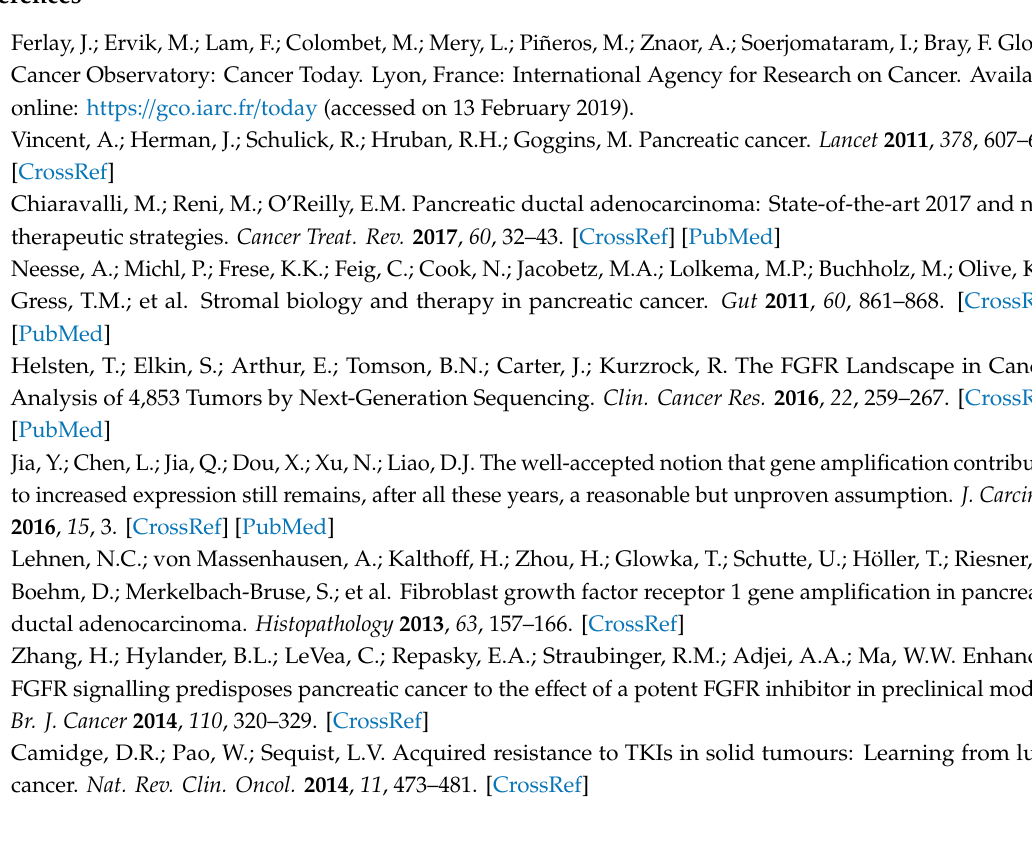
Figure S1. Aberrant FGFR1 and PARP1 expression is associated with cancer stem cell-like phenotype, regulates DNA repair, and modulates response to therapy in PDAC cells. Image showing the bioinformatics-generated gene expression-based heatmap of FGFR1, PARP1, ALDH1A1, ABCB1, RAD51, and H2AFX genes in the TCGA pancreatic adenocarcinoma cohort with the gene locus indicated; Figure S2. Dot and line plots of the correlation among FGFR1, PARP1, ALDH1A1, ABCB1, RAD51, and H2AFX gene expression in tumor pancreatic adenocarcinoma ( n = 178). TCGA, The Genome Cancer Atlas; R, correlation index; Figure S3: Full-sized blots of Figure 1B, Supplementary Figure S4: Full-sized blots of Figure 1D, Supplementary Figure S5. Full-sized blots of Figure 3D, Supplementary Figure S6. Full-sized blots of Figure 4D, and Supplementary Table S1: Western blot antibody sheet used in this